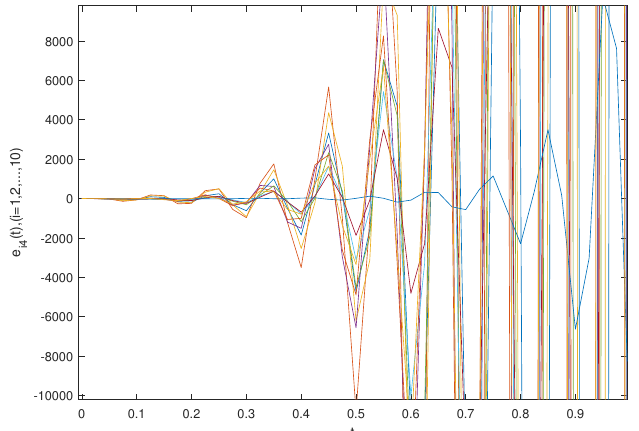
Figure 17. Synchronization errors e i 4 ( i = 1,2, · · · ,10 ) of the fractional-order system (34) and (35) without the controllers.